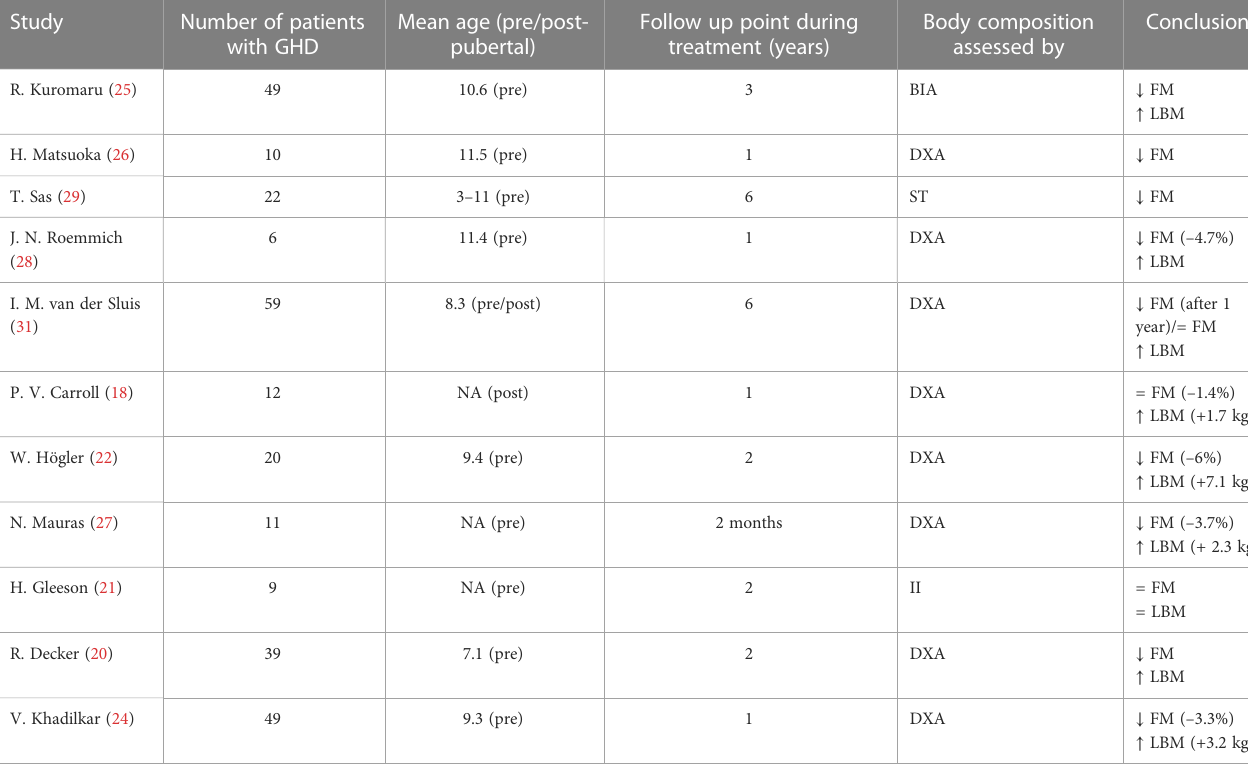
TABLE 1 Studies that evaluated body composition at baseline and during rhGH treatment in children with GHD. Study Number of patients with